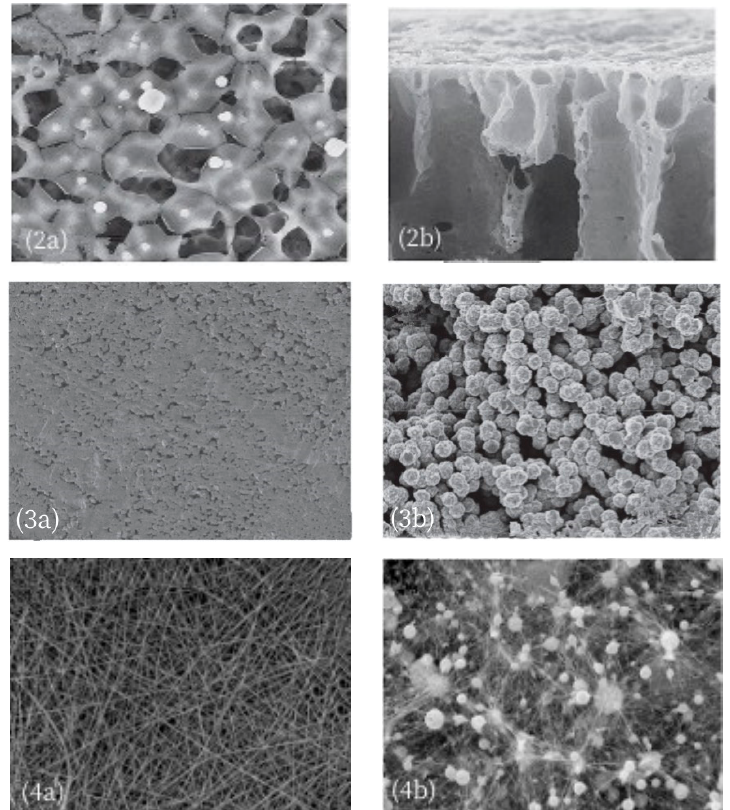
Figure 11. Surface ( a ) and cross-section ( b ) SEM images of ( 1 ) porous, ( 2 ) finger-like, ( 3 ) sphere-like pores and ( 4 ) ultrafine structure of PVDF membrane [45,103–105].